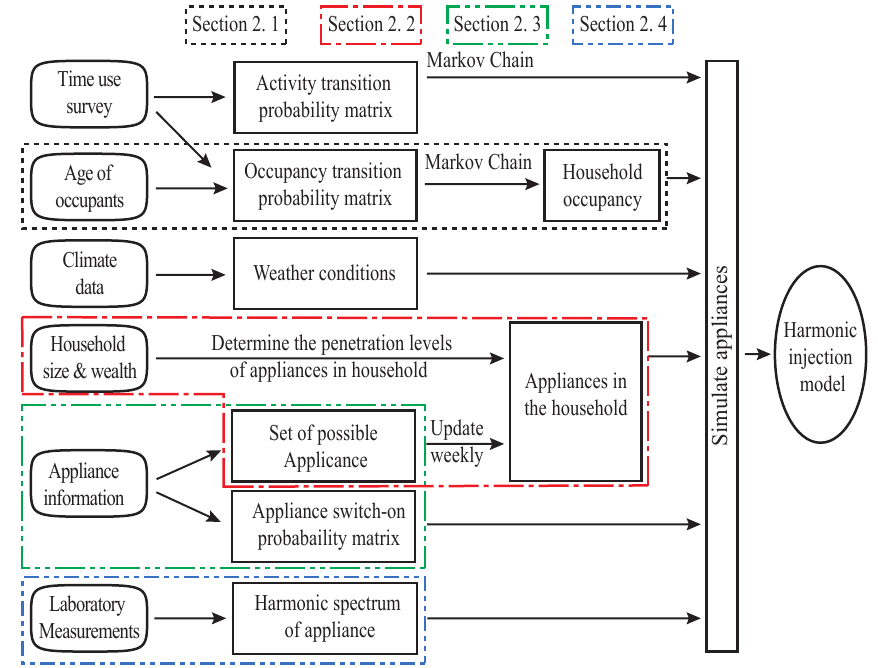
Figure 1. The methodology for modeling the residential harmonic